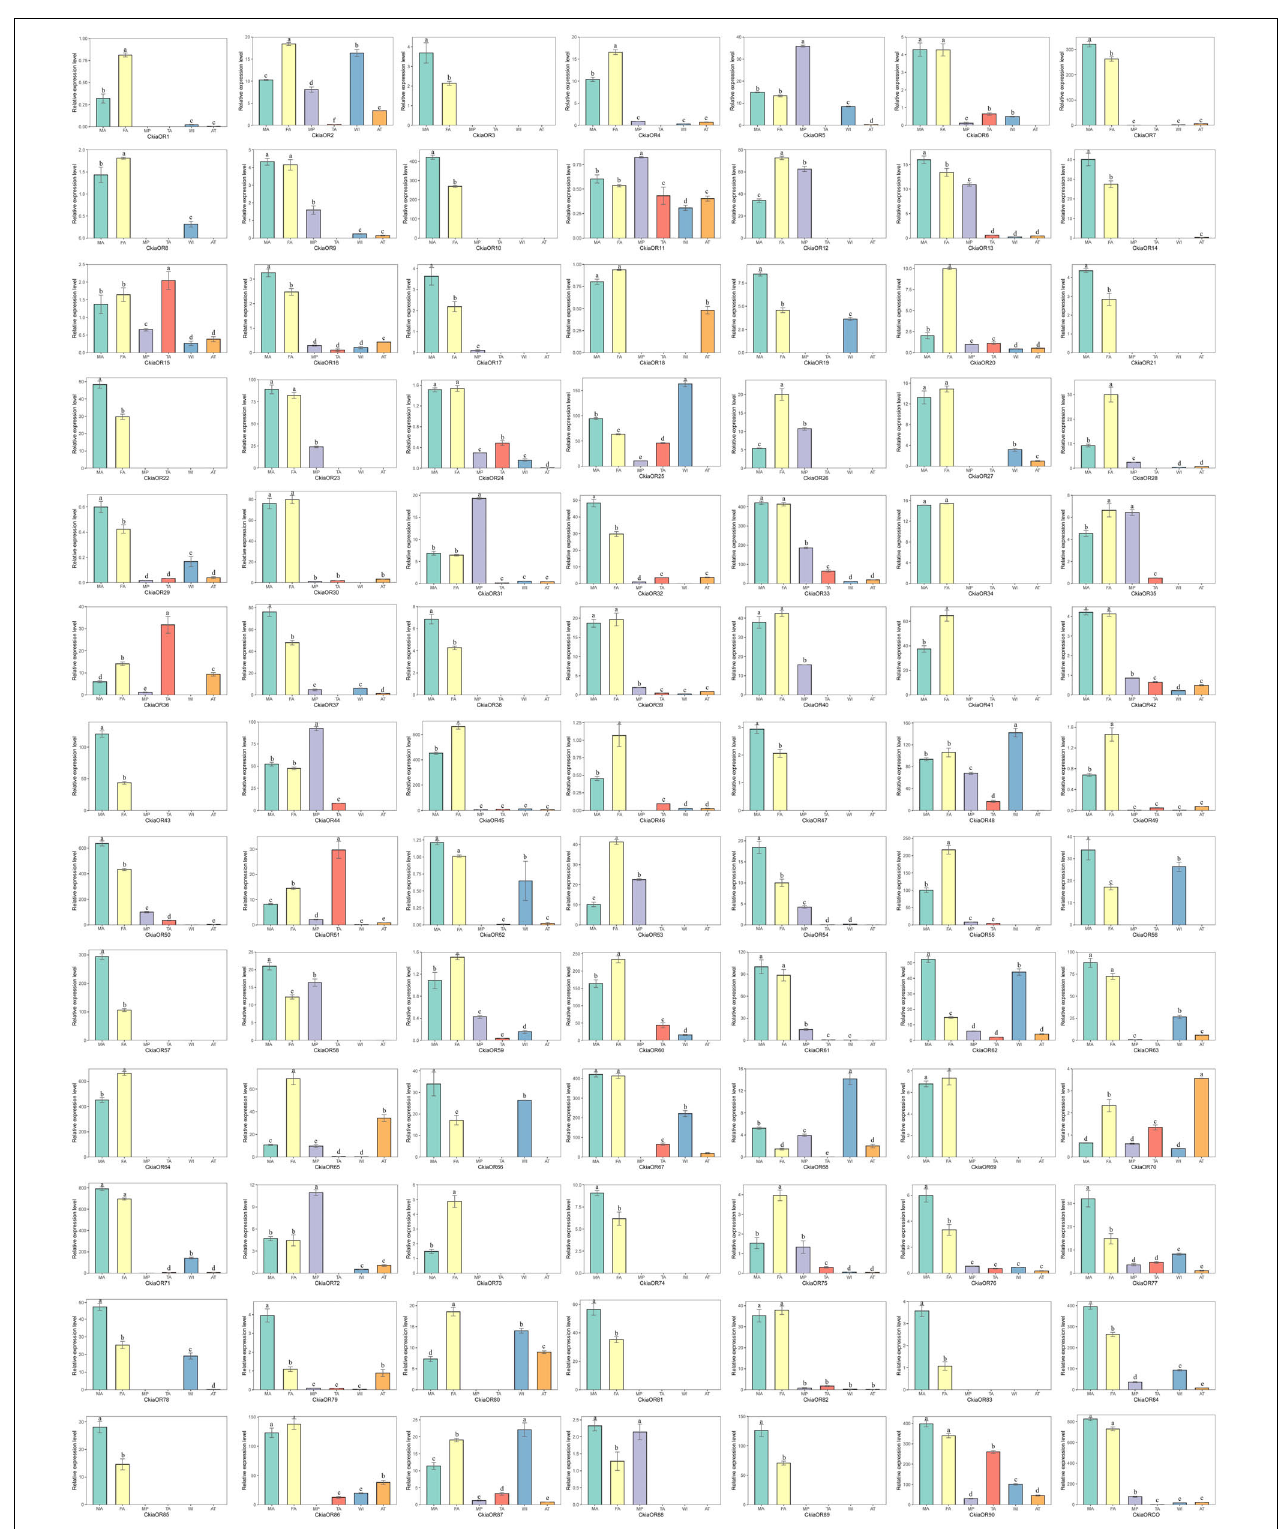
FIGURE 7 | Relative expression levels of ORs in different tissues of C. kiangsu as measured by RT-qPCR. FA, female antennae; MA, male antennae; MP, maxillary palps; TA, tarsi; WI, wings; AT, thoraxes-abdomens. The bar represents standard error and the different small letters above each bar indicate significant differences ( P <